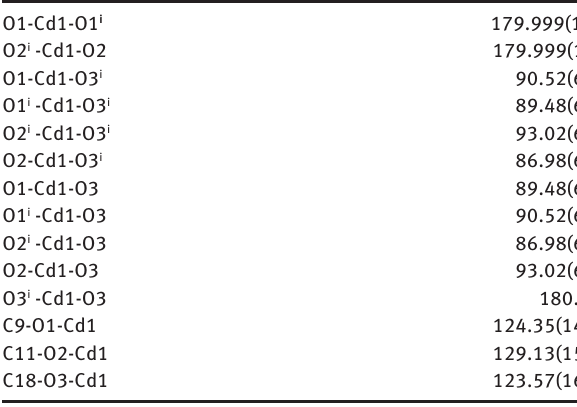
Figure 1: Coordination environments of the Cd atom.